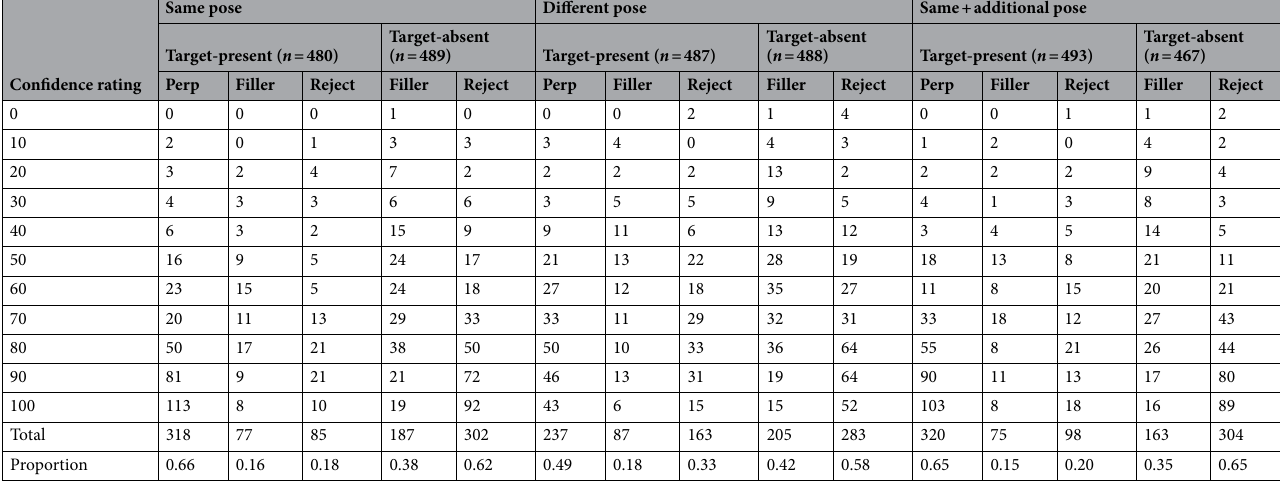
Table 2. Frequencies of perpetrator, filler and reject identification decisions by pose condition in Experiment